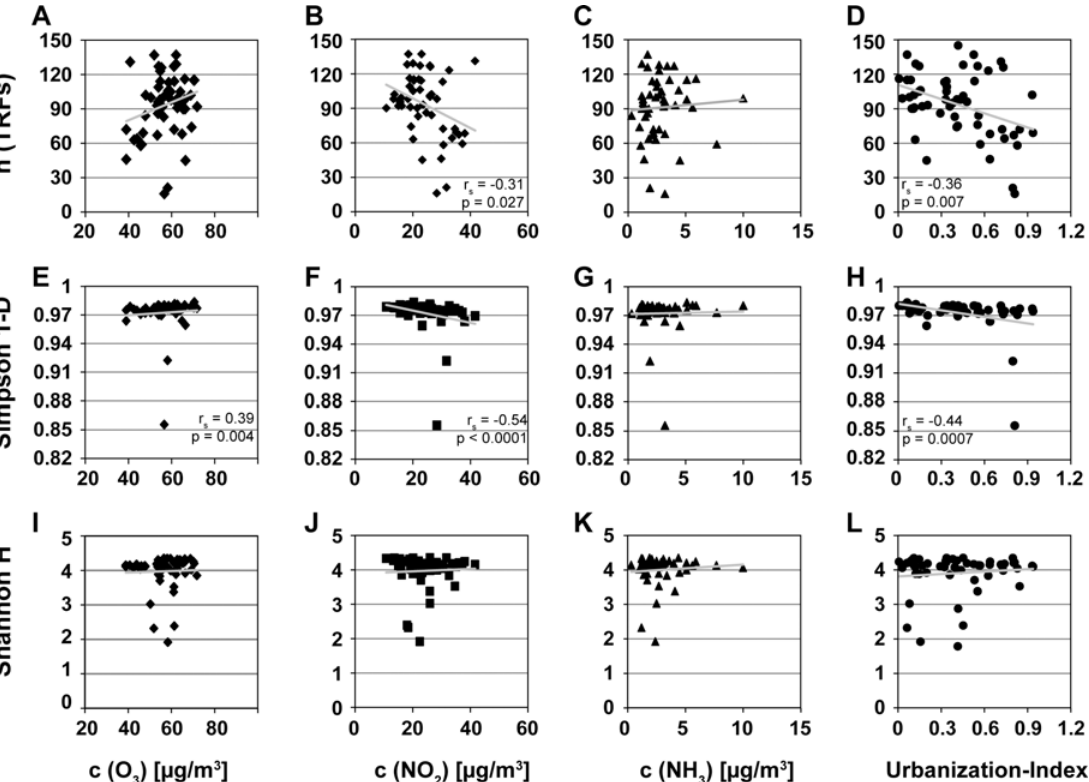
Fig 4. Spearman correlations of bacterial diversity on birch pollen to pollution parameter. Scatterplot including linear trend line, spearman correlation values rho and significance level p of diversity indices (Shannon H/Simpson 1-D) and parameter (number of fragments n(tRFs)) of bacterial pattern on birch pollen ( Betula pendula 2014, n = 55) with pollution measurements. A-D Correlation of n(tRFs) and pollution parameters ozone O 3 (r s = 0.21, p = 0.13), nitrogendioxid NO 2 (r s = -0.31, p = 0.027), ammonia NH 3 (r s = 0.14, p = 0.34) and the urbanization-index (r s = -0.36, p < 0.01). E-H Correlation of Simpson diversity Index 1-D and pollution parameters O 3 (r s = 0.39, p = 0.004), NO 2 (r s = -0.54, p < 0.0001), NH 3 (r s = 0.01, p = 0.94) and the urbanization-index (r s = -0.44, p = 0.001). I-L Correlation of Shannon diversity Index H and pollution parameters O 3 (r s = 0.19, p = 0.17), NO 2 (r s = -0.14, p = 0.31), NH 3 (r s = 0.01, p = 0.89) and the urbanization-index (r s = 0.06, p = 0.67).